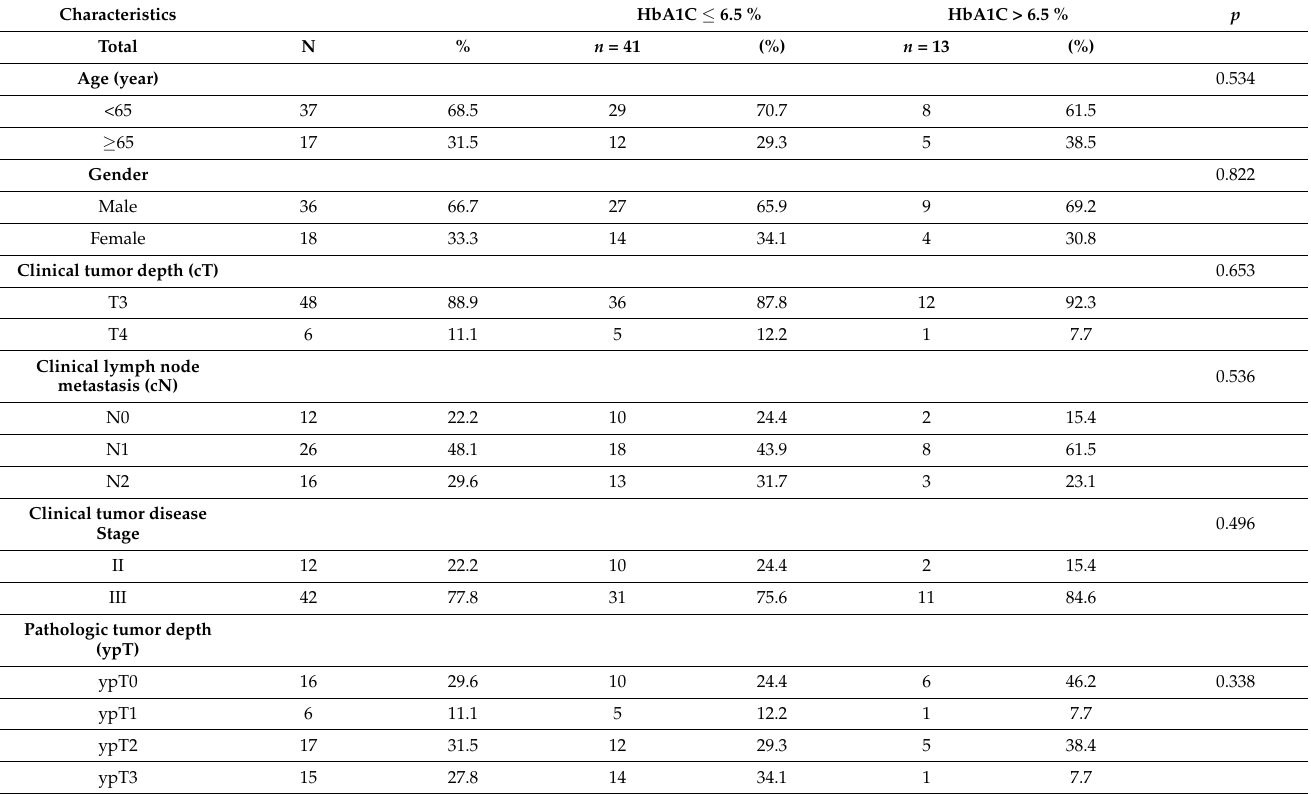
Table 1. Characteristics of 54 rectal cancer patients receiving preoperative CCRT and association between HbA1c level with the CCRT efficacy. The Chi-square test was used for statistical analysis. The statistical significance level was *, p <